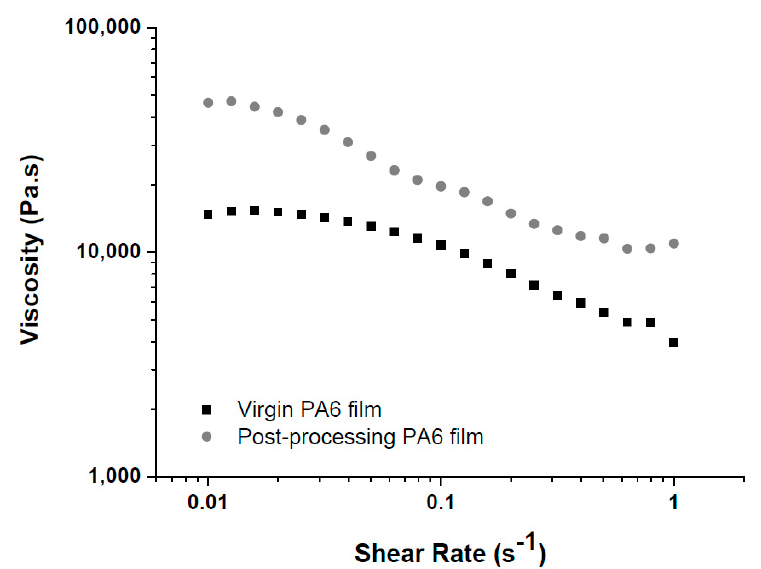
Figure 3. Curves of viscosity as a function of the shear rate obtained by deformational rheometry of the virgin and post-processing PA6 films.